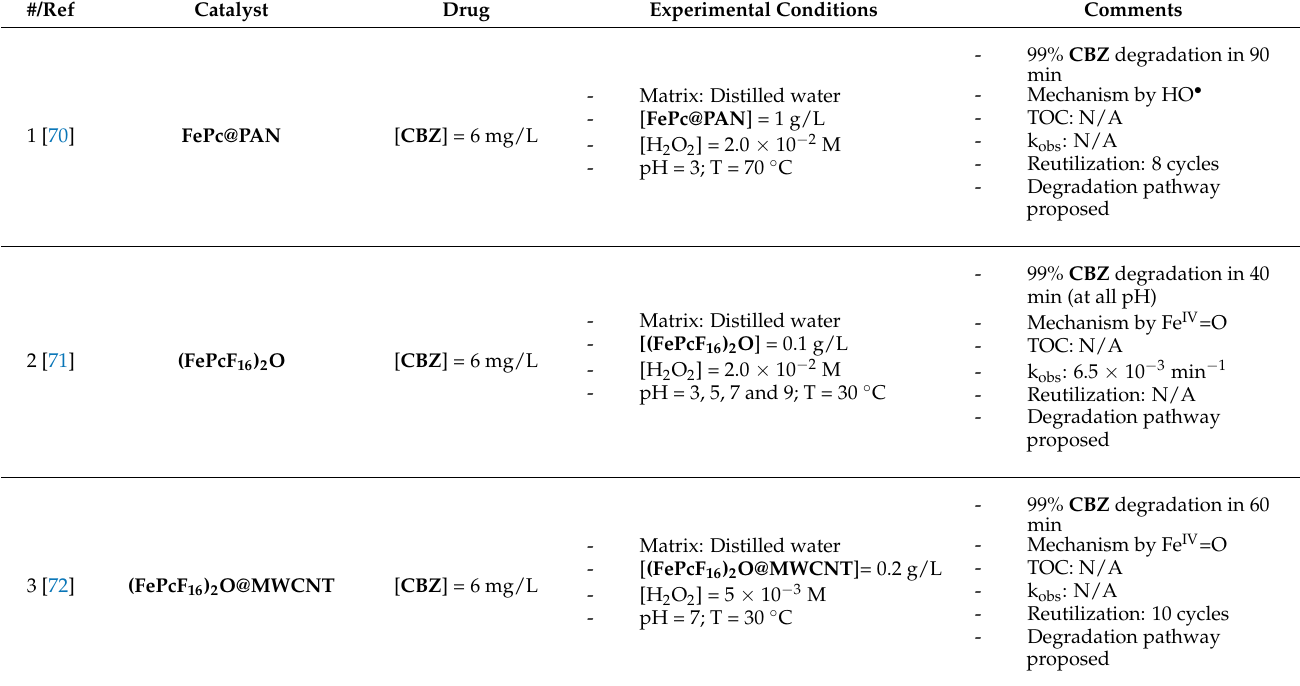
Figure 12. Structures of tetrapyrrolic macrocycles (TPM) used as catalysts for degradation of carba- mazepine. Table 6. Oxidative chemical degradation of neurological-system pharmaceuticals using TPM-based